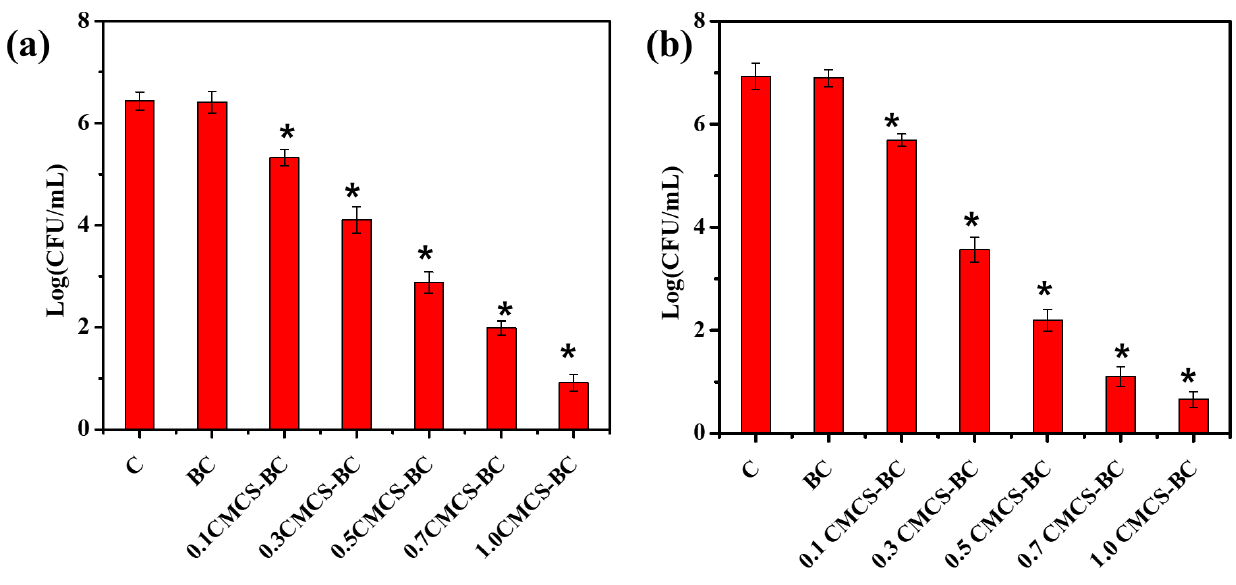
Figure 8. Antibacterial activity of CMCS–BC hydrogels against with ( a ) E. coli and ( b ) S. aureus bacteria (N = 3, * p < 0.05).